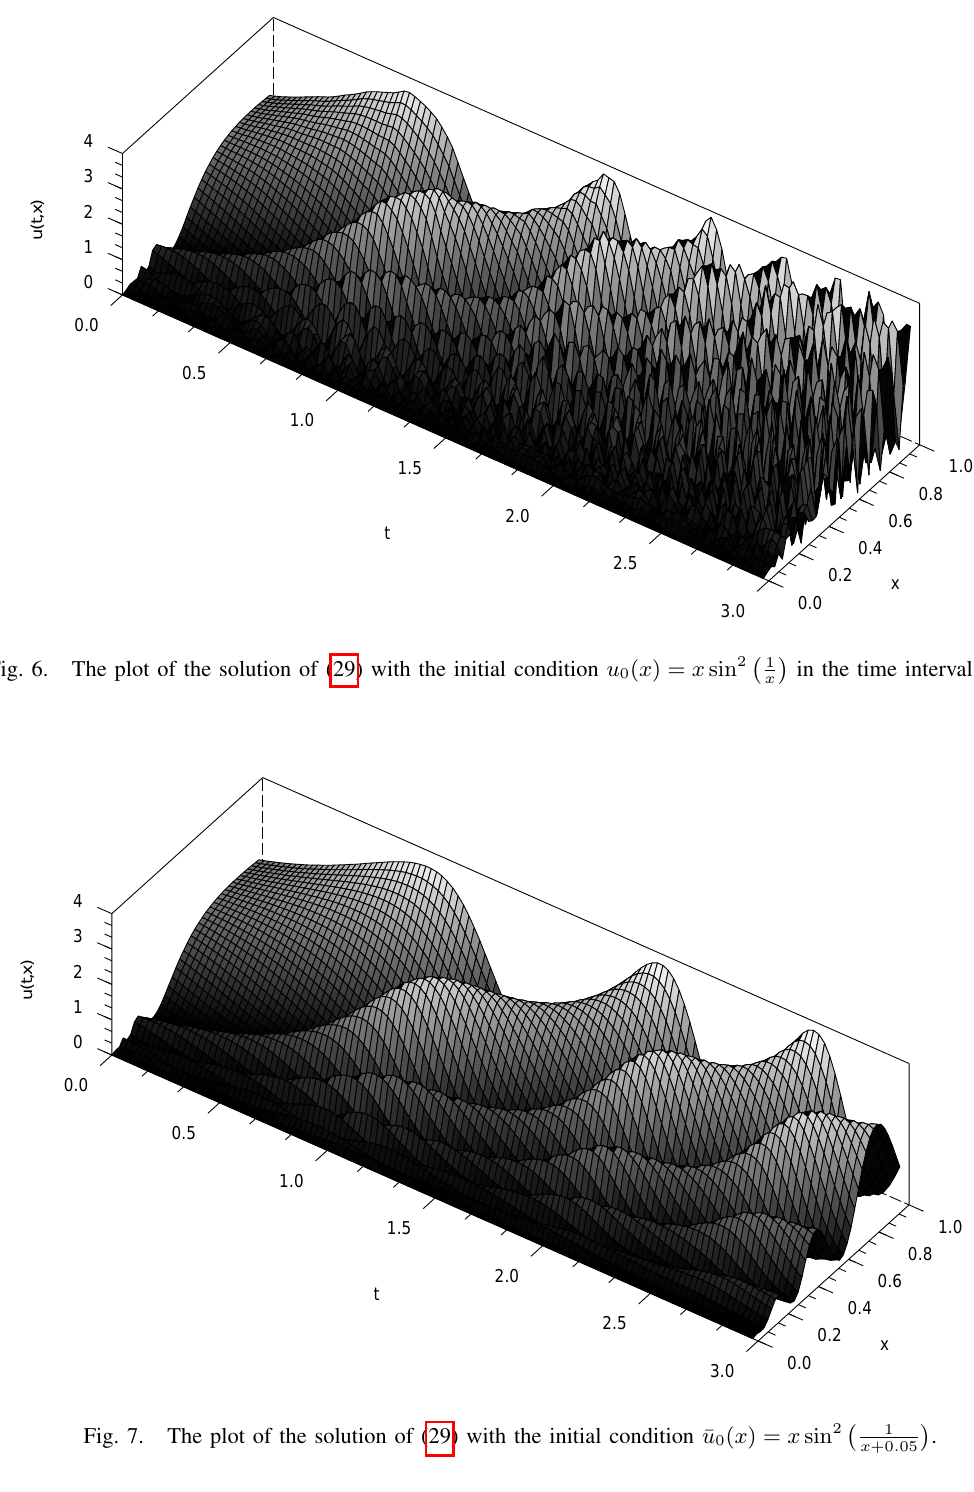
Fig. 7. The plot of the solution of (29) with the initial condition ¯ u 0 ( x ) = x sin 2 (cid:0) 1